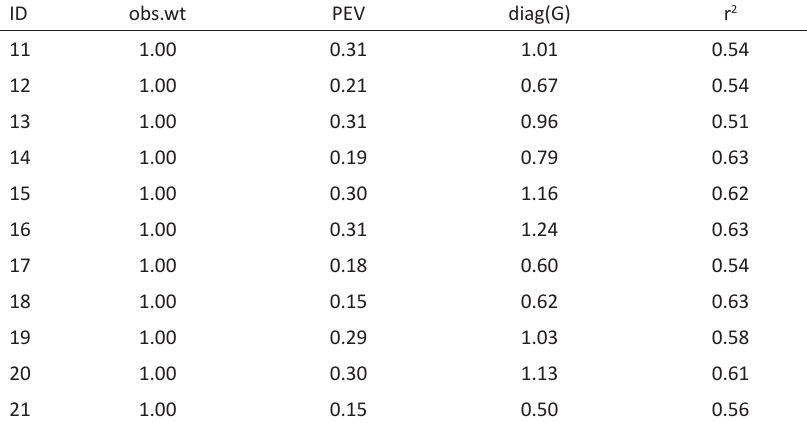
Table 4. Output file from the snp_blup_rel program for the example case. The columns